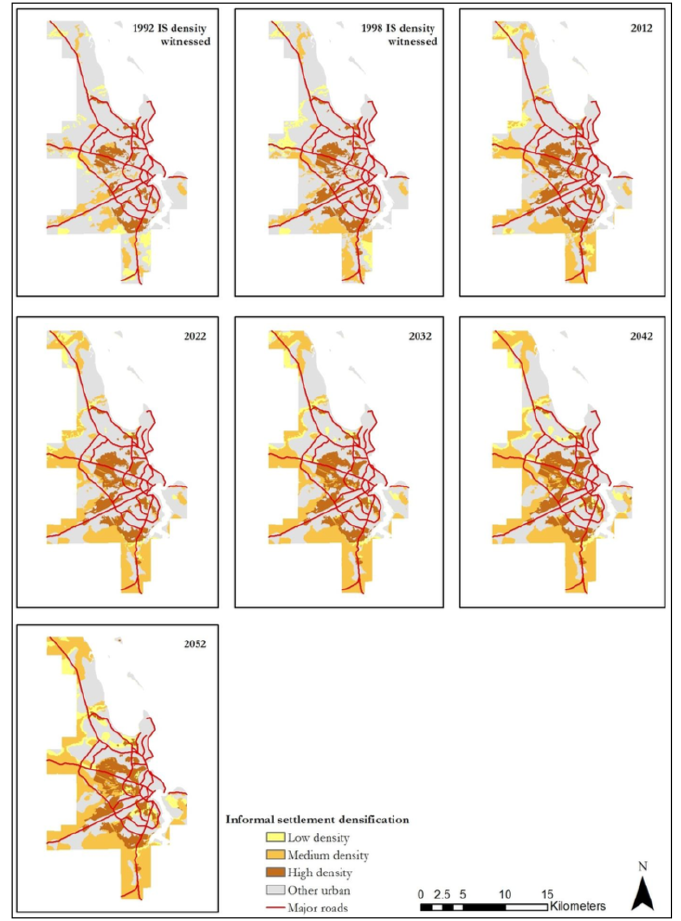
Figure 3. Projected densification of informal settlements in Dar es Salaam (1992–2052). Source: Abebe